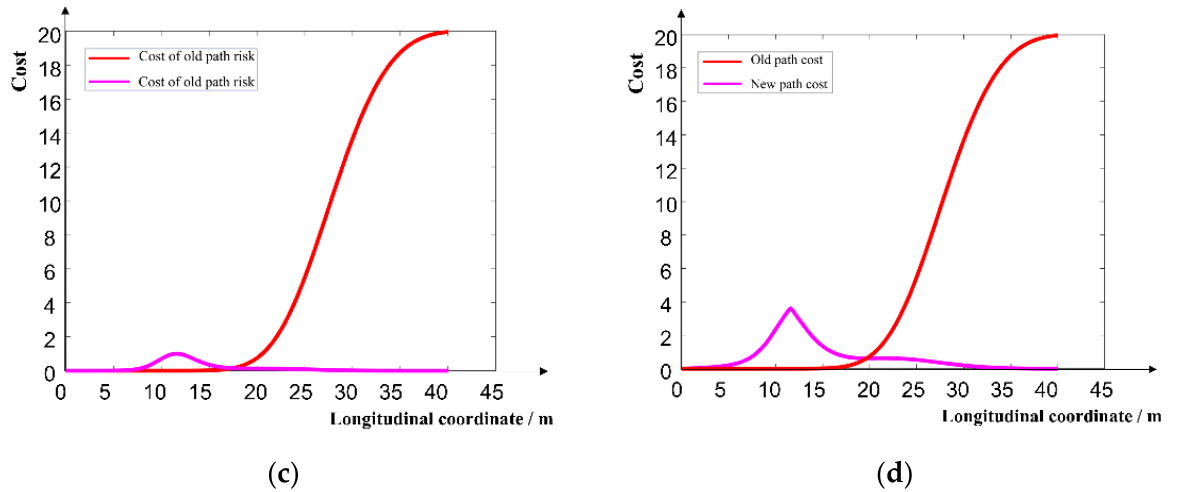
Figure 9. Comparison of new and traditional paths in the simulation scenario: ( a ) cost of smoothness of path; ( b ) cost of lateral offset from road centerline; ( c ) path risk cost; ( d ) path cost.